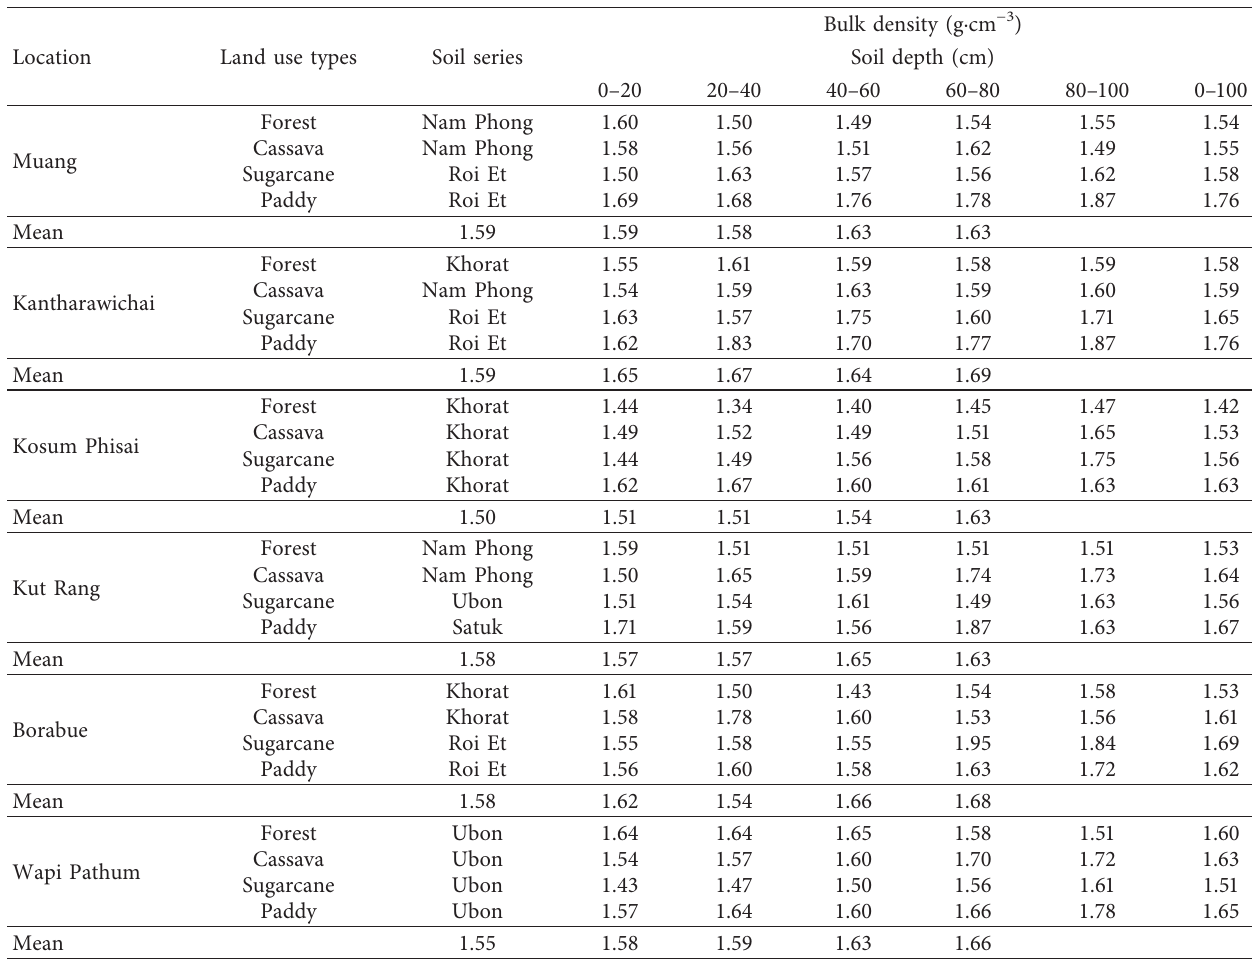
Table 3: Soil series and bulk density in soil profile under different land uses.